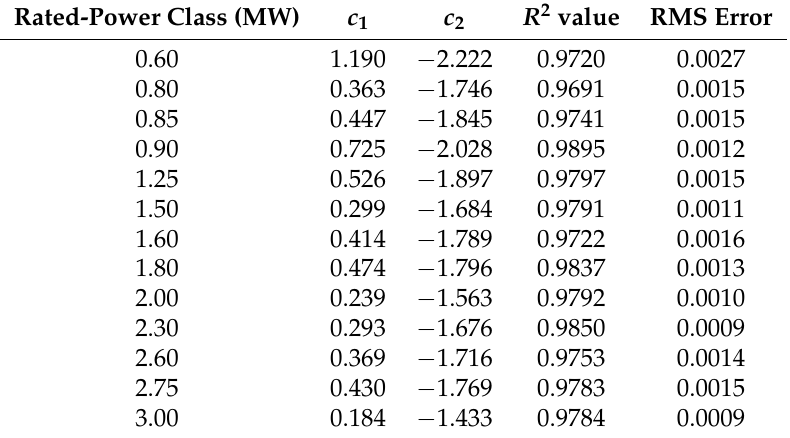
Table 3. Details of the polynomial regression curves: representing the variation of minimized COE with AWS (for each turbine